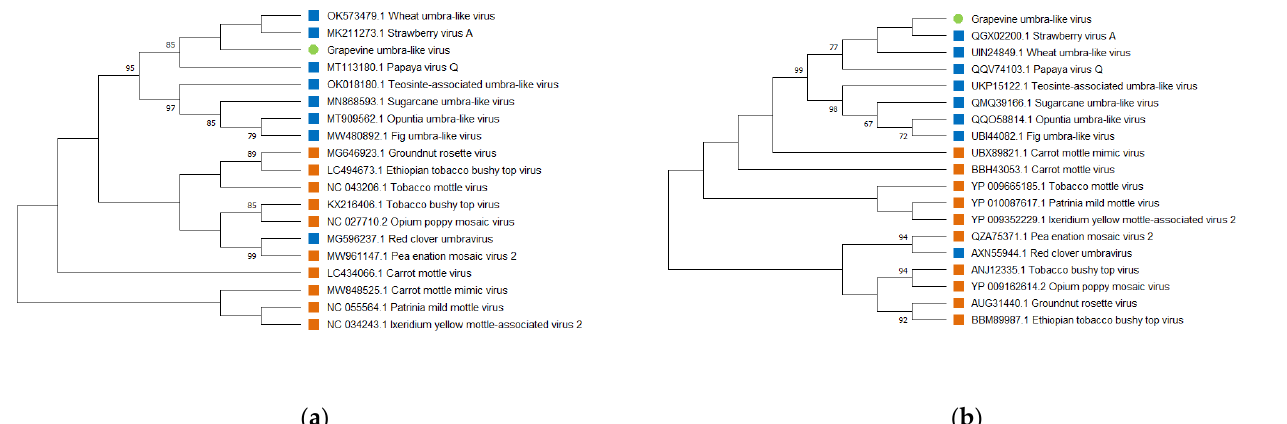
Figure 3. Phylogenetic analysis of ( a ) nucleotide sequences, ( b ) amino acids sequences of RNA-dependent RNA polymerase (RdRp) gene of a Russian isolate of Grapevine umbra-like virus (marked with a green label), representatives of the genus Umbravirus (marked with an orange label) and unclassified Umbravirus (marked with a blue label). The tree was constructed using the Maximum Likelihood method. The numbers at the nodes indicate bootstrap values >60% (1000 replicates). GenBank accession numbers for each isolate are presented in Supplementary Table